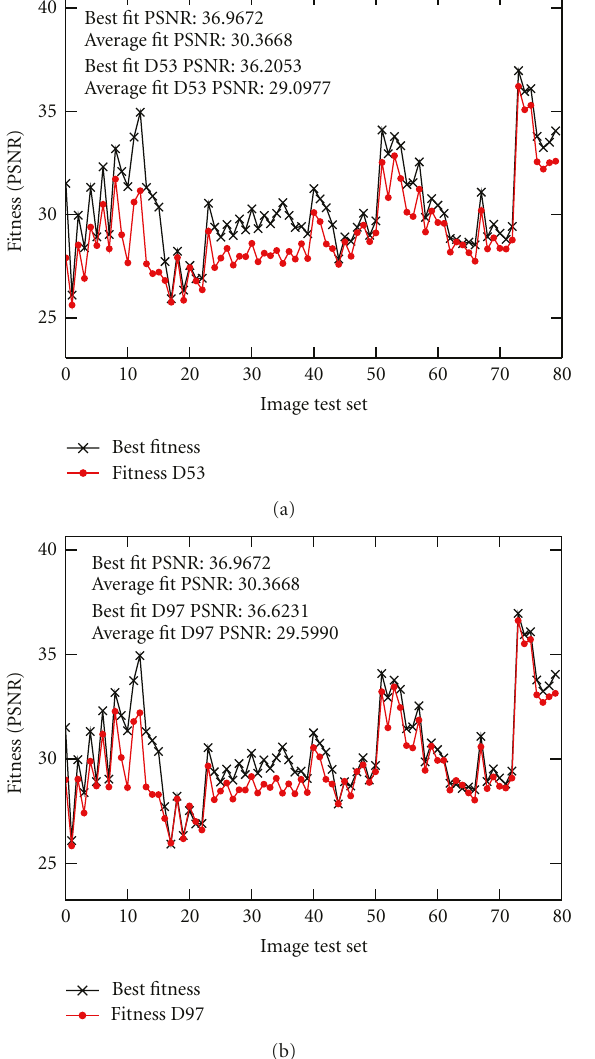
Figure 13: Performance of the best evolved individual for Floating point arithmetic and Gaussian mutation against the whole test set: (a) for D5/3 and (b) for D9/7 wavelets.